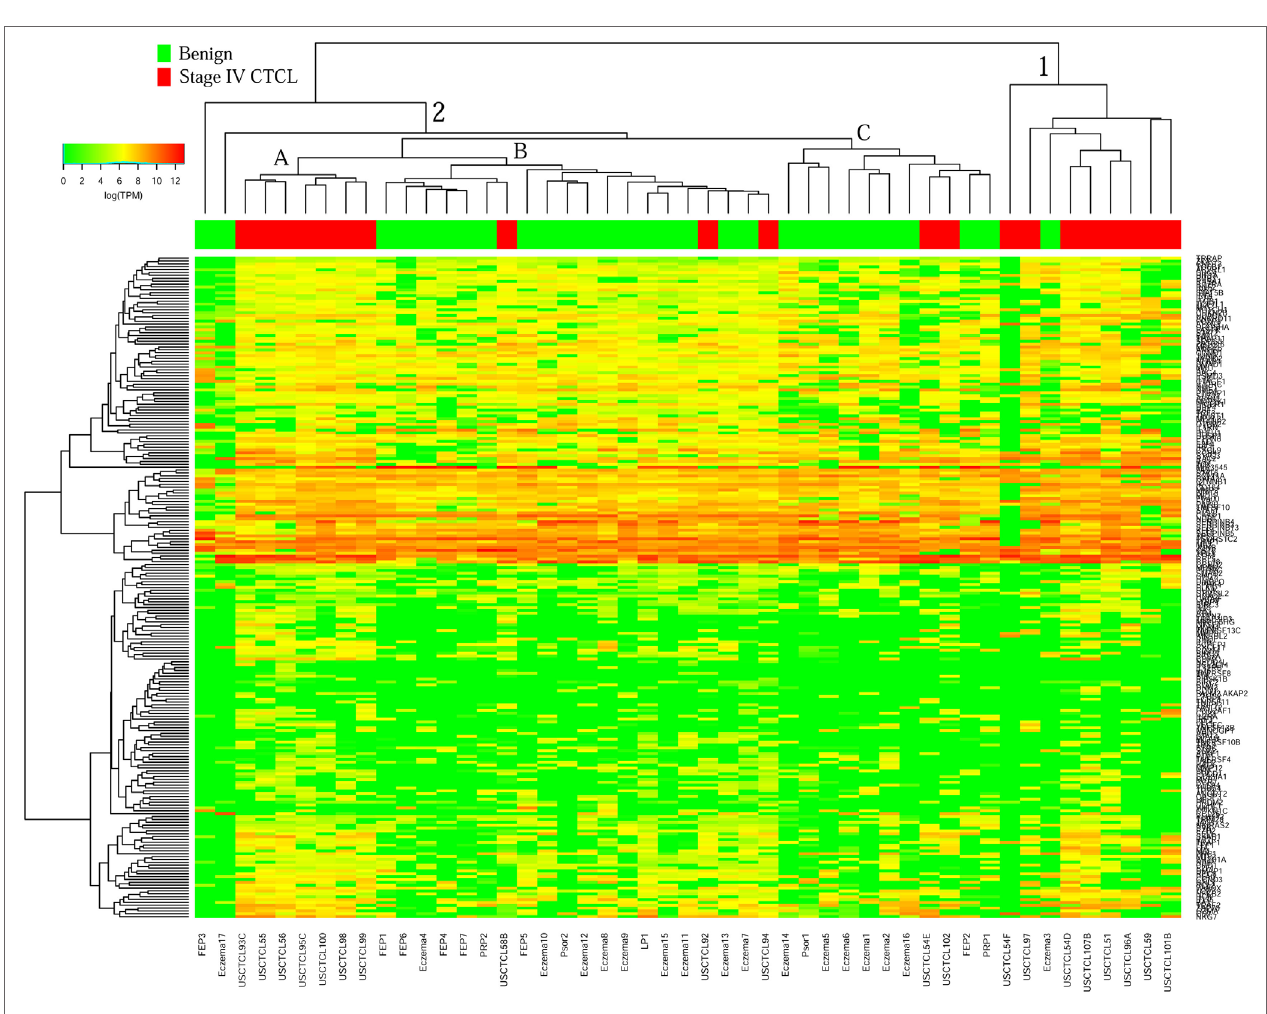
FigUre 4 | Unsupervised hierarchical clustering analysis based on TruSeq targeted RNA gene expression analysis of 284 select genes in benign inflammatory dermatoses (green), vs. ≥ 2009 stage IV formalin-fixed paraffin-embedded cutaneous T-cell lymphoma (CTCL) samples (red). A color key refers to gene expression in log(transcripts per